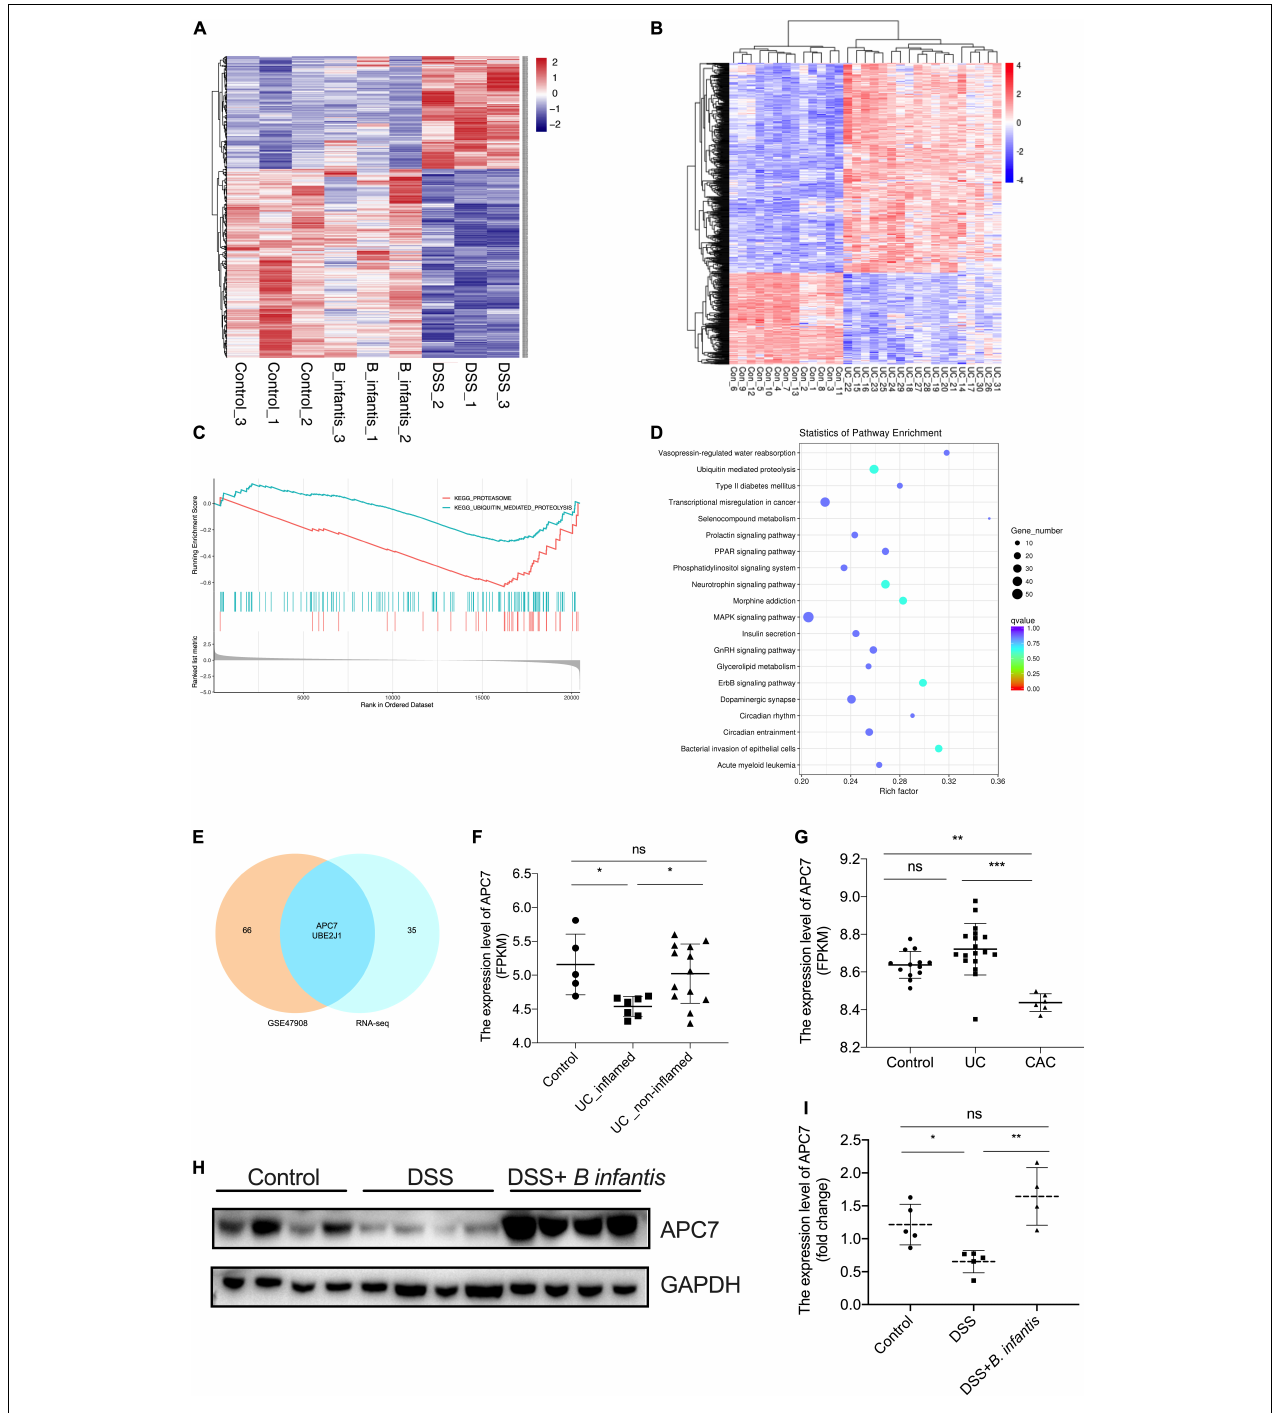
FIGURE 5 | Identification of APC7 as a molecule related to B. infantis treatment. (A) Heatmap of differentially expressed mRNAs in colon tissues from mice in the control, DSS-treated, and B. infantis treatment groups. (B) Heatmap of differentially expressed mRNA in colons tissues obtained from healthy controls, patients with UC, from GSE47908. (C) GSEA analysis of differentially expressed mRNAs in colon tissues of mice obtained from control, DSS-treated, and B. infantis administration groups. (D) KEGG analysis of differentially expressed mRNA in colon tissues obtained from healthy controls, patients with UC from GSE47908. (E) Venn plot of genes involved in the ubiquitin-mediated proteolysis pathway enriched in RNA-seq results and GSE47908. (F,G) The expression level of APC7 were analyzed in colon tissues obtained from healthy controls, patients with UC, and patients with CAC, from GSE47908 and GSE9452. The expression of APC7 was determined using western blotting assays (H) and qRT-PCR (I) in colon tissues of mice obtained from control, DSS-treated, and B. infantis administration groups. * p < 0.05, ** p < 0.01, *** p < 0.001, ns, no significance.